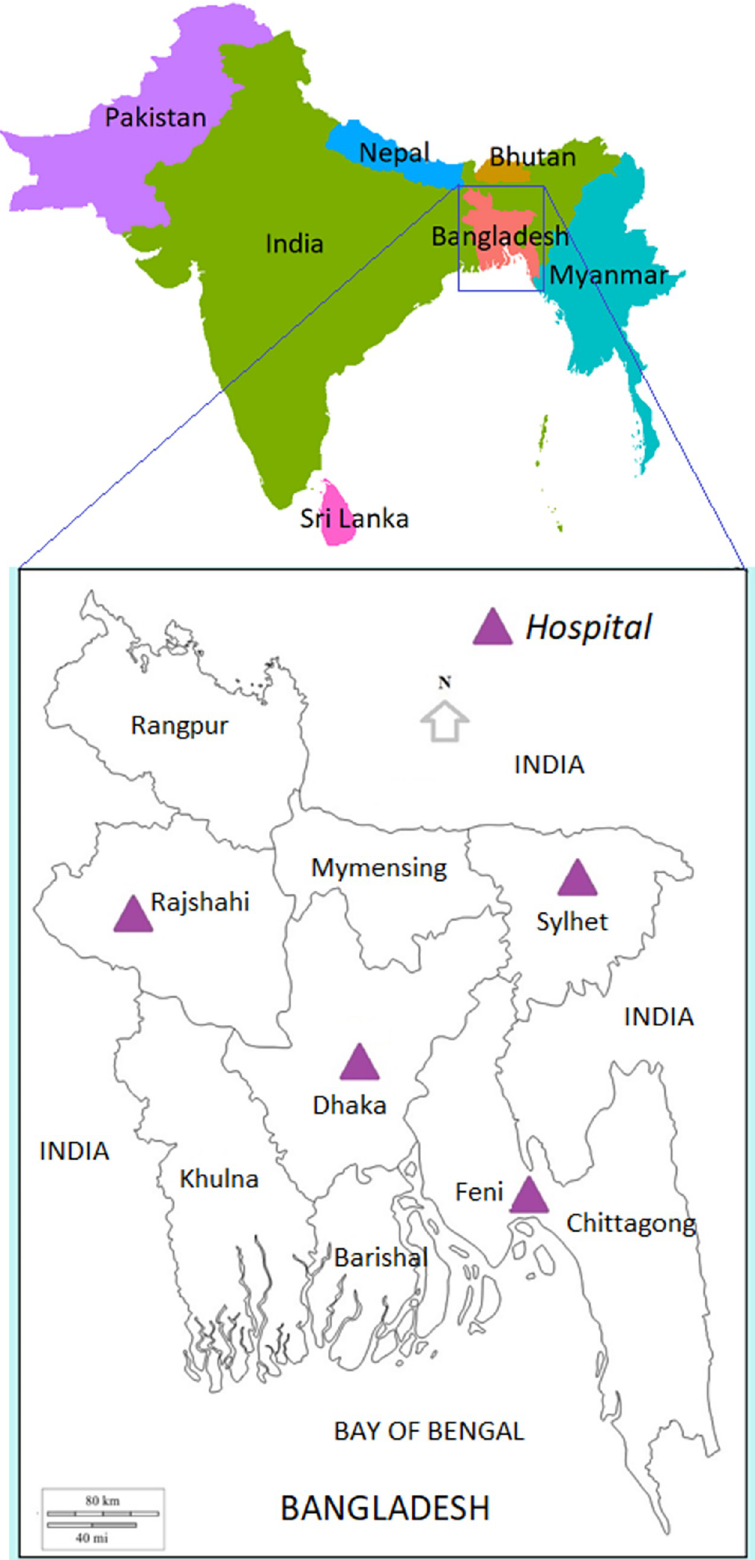
Fig 1. Bangladesh map showing hospital locations for acute febrile illness (AFI) surveillance in Bangladesh. https://doi.org/10.1371/journal.pone.0273902.g001 PLOS ONE | https://doi.org/10.1371/journal.pone.0273902 September 1,